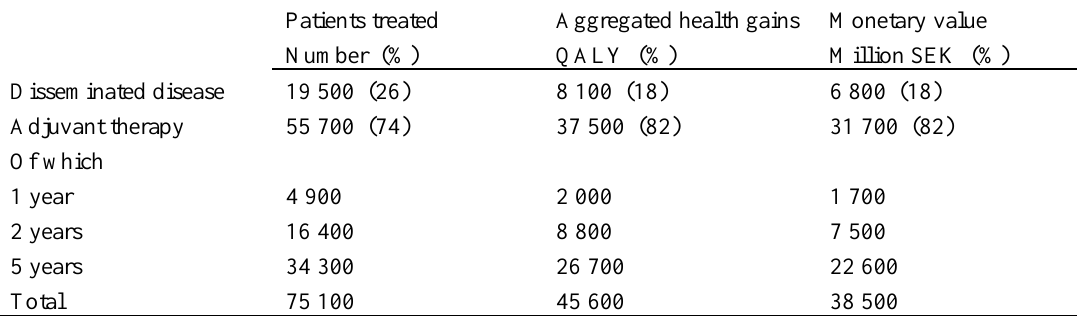
Table 2: Number of patients treated, aggregate health gains measured as QALYs, and monetary value of health gains (million SEK) from tamoxifen in Sweden during 1979-2004. Source Lundqvist et al (2013b). Patients treated Aggregated health gains Monetary value Number (%) QALY (%) Million SEK (%) Disseminated disease 19 500 (26) 8 100 (18) 6 800 (18) Adjuvant therapy 55 700 (74) 37 500